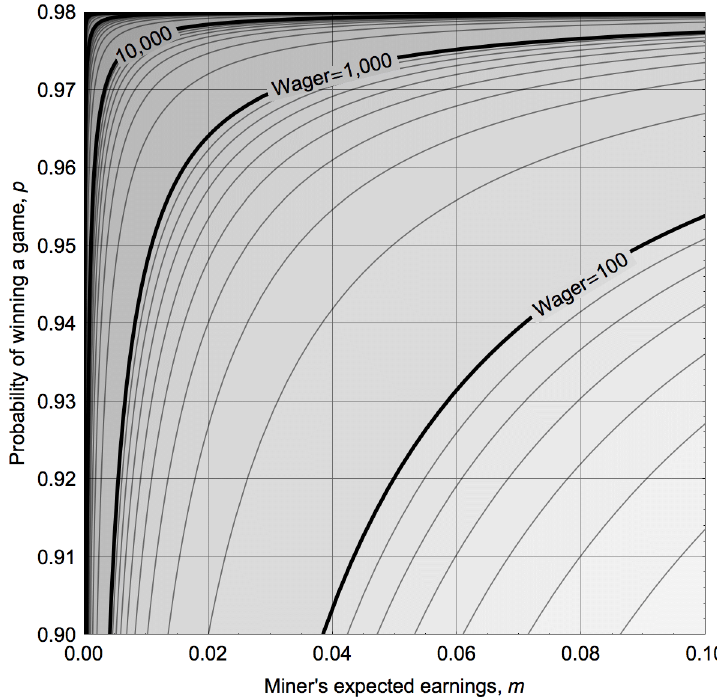
Fig. 2. Minimum wager 𝑤 required to profitably game the “delayed lottery” contract. Here the values used are ℎ = 0.98 , 𝑛 = 2 , 0.9 < 𝑝 < 0.975 with 0.005 steps, and 0.01 < 𝑚 < 0.1 with 0.01 steps. Black curves at constant values of 𝑤 are